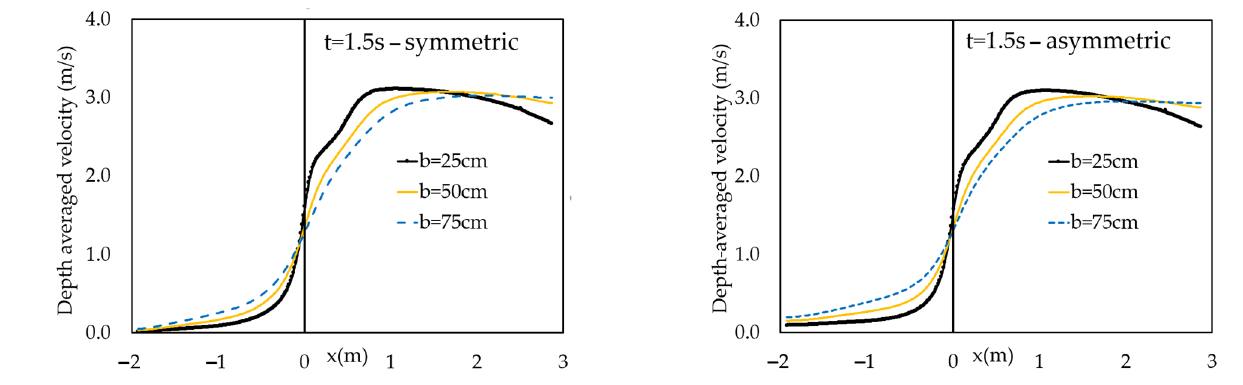
Figure 7. Depth − average velocity profiles at central line of dam gate at t = 1.5 s.